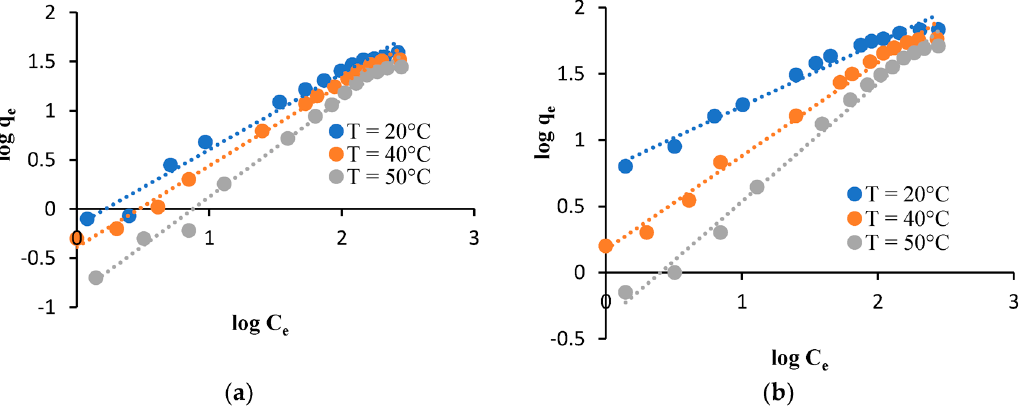
Figure 8. Plots of Freundlich isotherm for: ( a ) pectin beads and ( b ) pectin-[Sb(TPP)Cl 2 ] beads (1%).